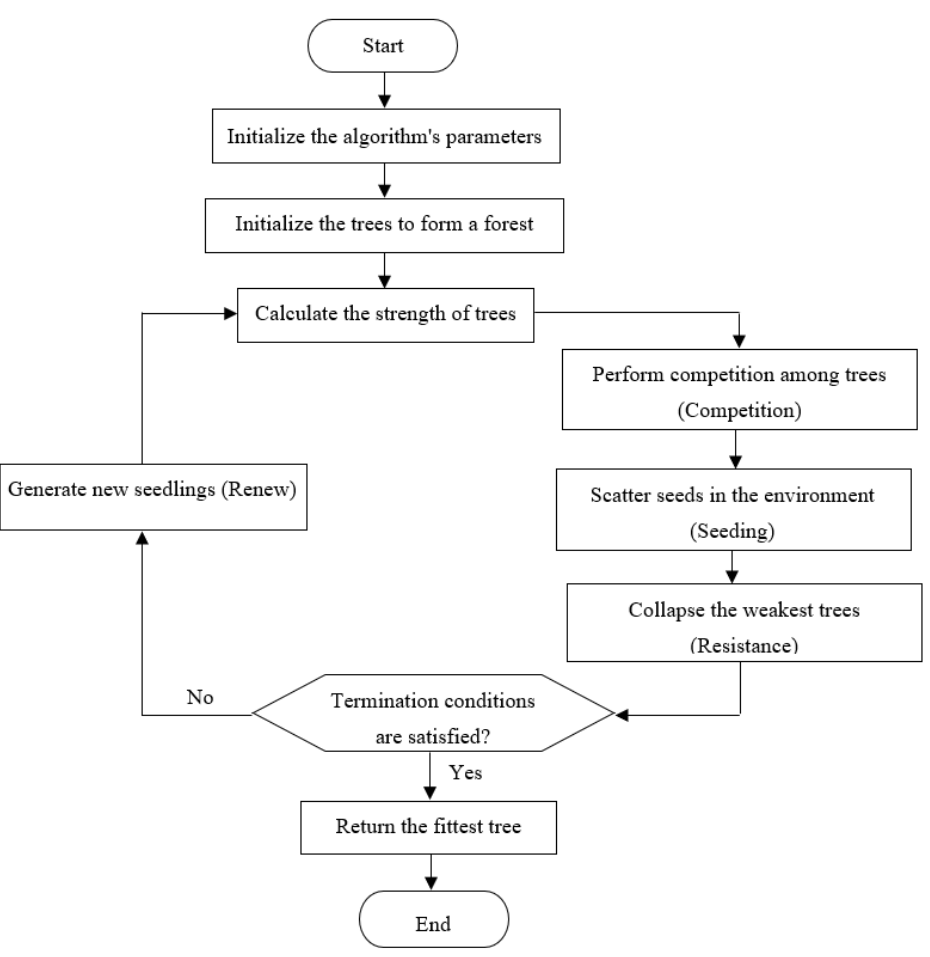
Figure 2. Flowchart of the season optimization (SO) algorithm.